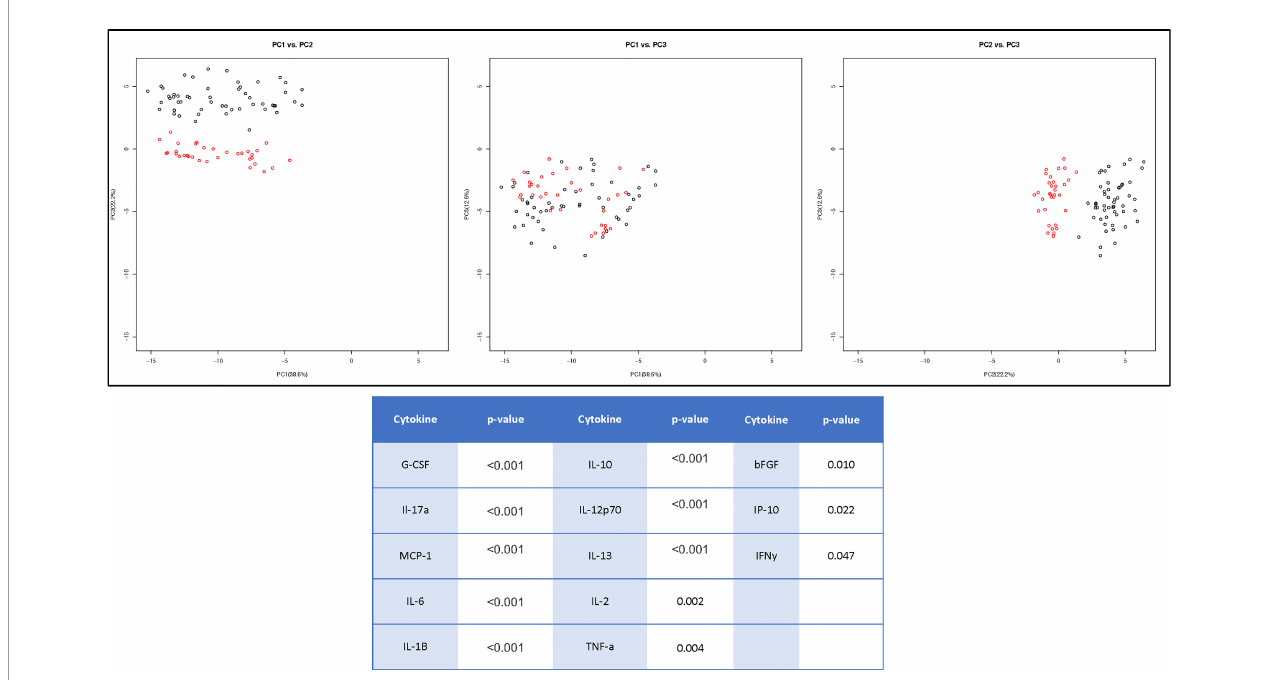
Adjusted(age,sex,BMI,painfuljointcount)oddsratiodescribinglikelihoodofundergoingsurgicaltreatmentwithincreasedlevelsofcytokineexpressioninnon-surgicallymanaged(n=44) or surgically managed (n=39) patients at baseline. Bold values indicate statistically signi fi cant